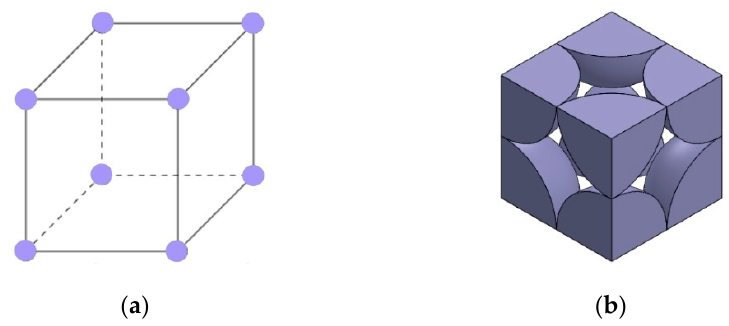
Table 9. Values of PF for several situations.